Question: Provide a publication-style caption for this figure.
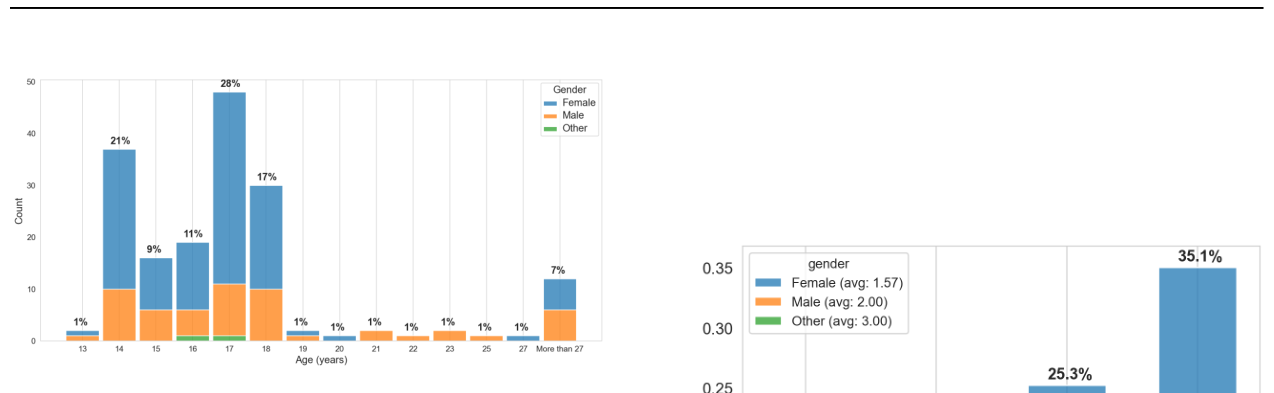
Answer: Age distribution of participants.